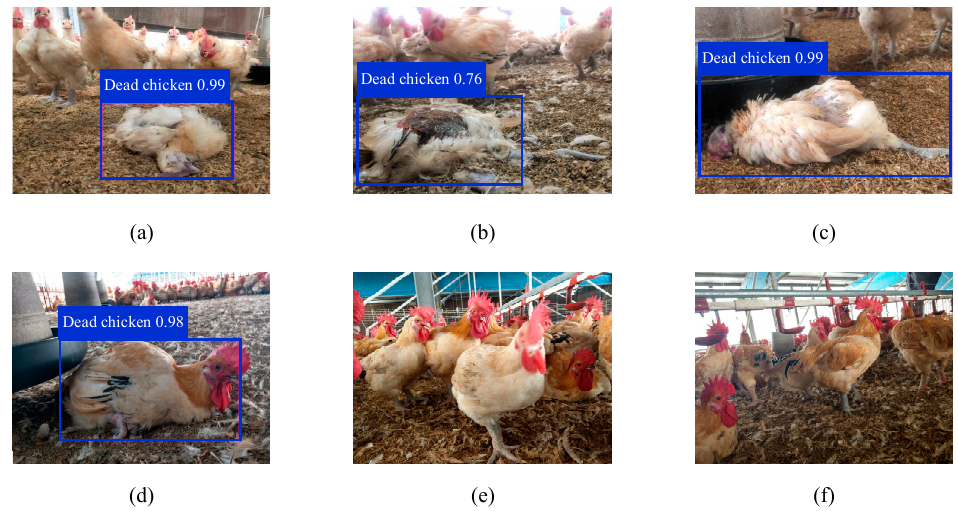
Figure 10. Identification results obtained with the developed system: ( a – c ) successful identification of dead chickens, ( d ) healthy chicken identified as a dead chicken, and ( e , f ) healthy chickens not identified.